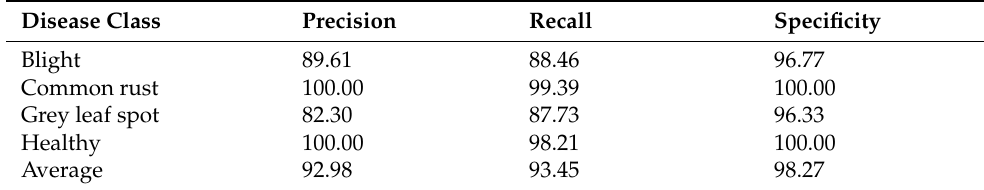
( a ) ( b ) Figure 7. Confusion matrix of shallow VGG with Xgboost ( a ) potato diseases ( b ) tomato diseases. Table 5. Performance evaluation of individual classes of corn diseases using VGG and Xgboost.